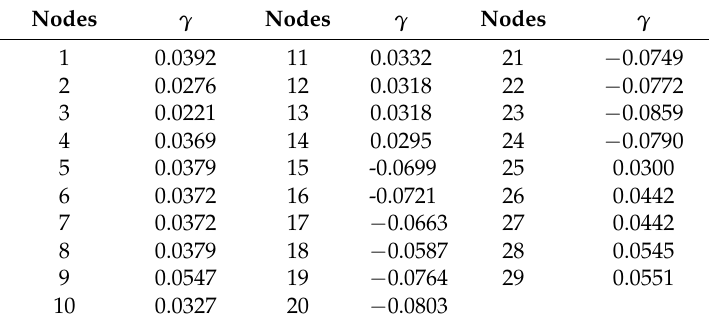
Table 3. Difference of the minimum edge weights cumulative summation.